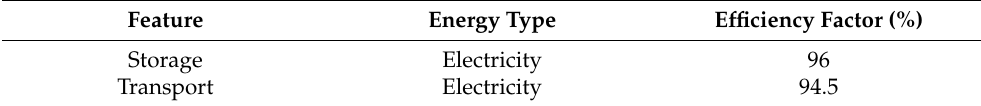
Table 13. Electricity storage and transport efficiency [61].